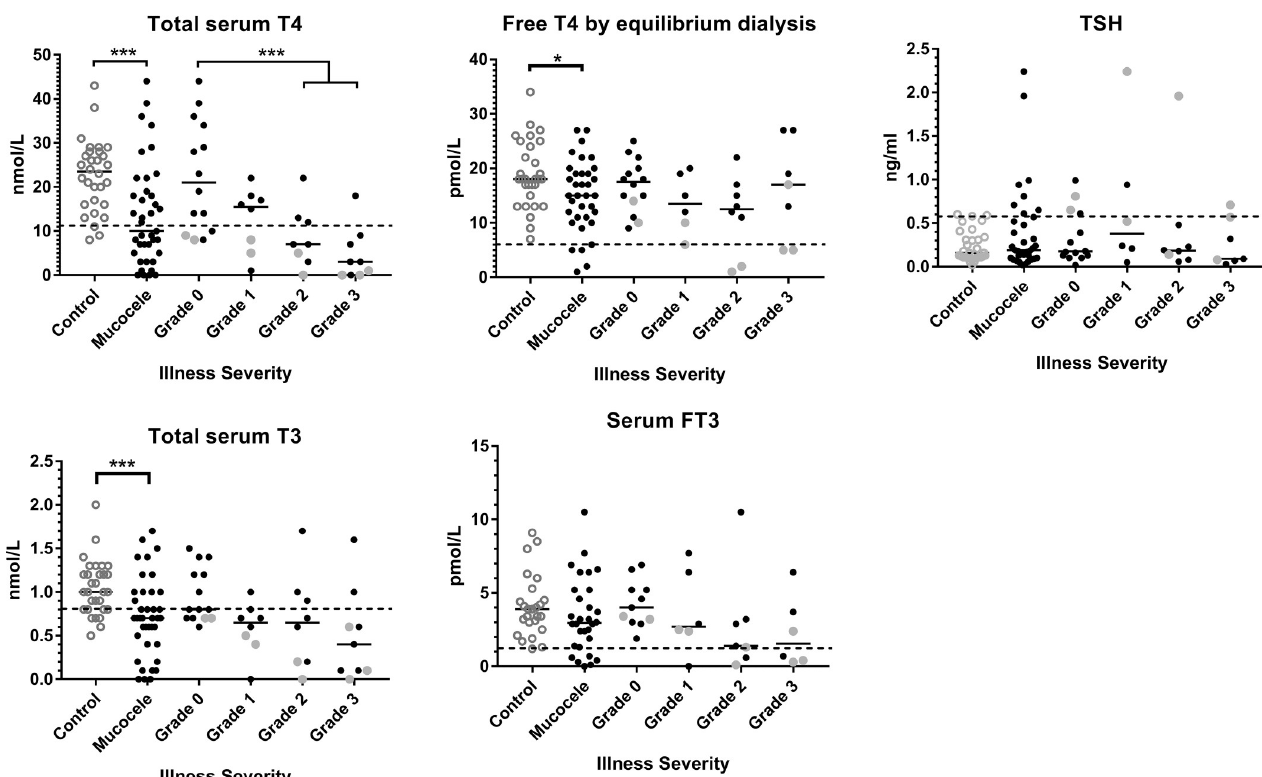
Fig 4. Thyroid hormone assay results obtained from control dogs and dogs diagnosed with gallbladder mucocele formation. For dogs with gallbladder mucocele formation, values are shown subdivided by non-thyroidal illness severity score. The horizontal dashed line designates lower limit of the laboratory reference range (total T4, FT4, total T3, and FT3) and upper limit of the laboratory reference range (TSH). Among dogs with gallbladder mucocele formation, solid gray data points represent dogs meeting proposed criteria for diagnosis of hypothyroidism. Bar = median. � p < 0.05 and ��� p < 0.001 Kruskal Wallis One Way ANOVA on Ranks (Benjamini-Hochberg FDR � 0.15). Significant differences between illness severity groups, if present, determined by post-hoc Dunn’s